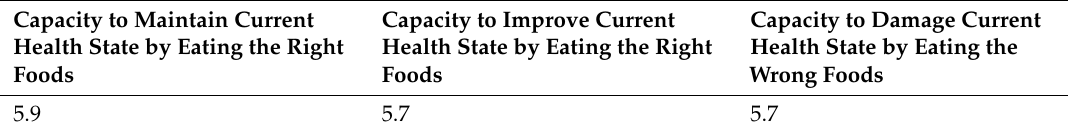
Table 7. Perceived control of the capacity to influence health towards one of the three possible directions: maintain, improve, damage (average scores at total sample level).